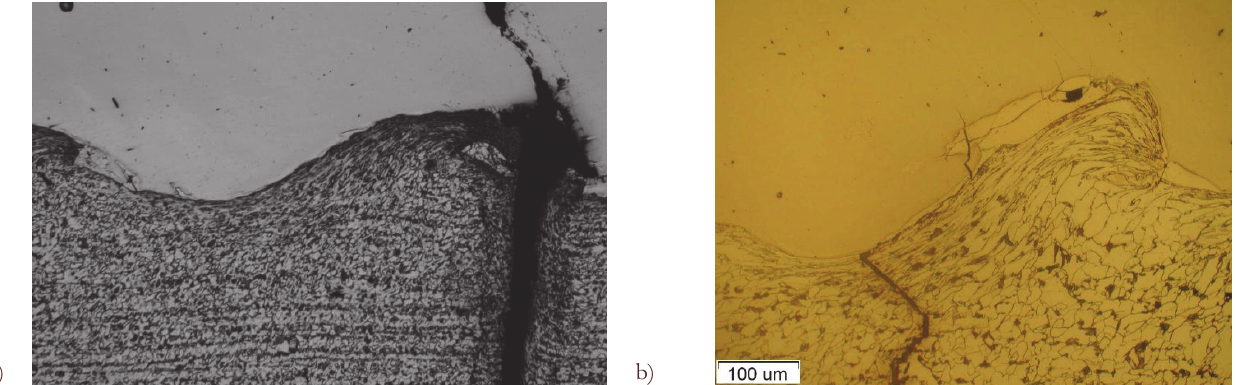
Figure 7: Fatigue crack paths of the in zirconium-steel joint a) without melted layer, b) with melted